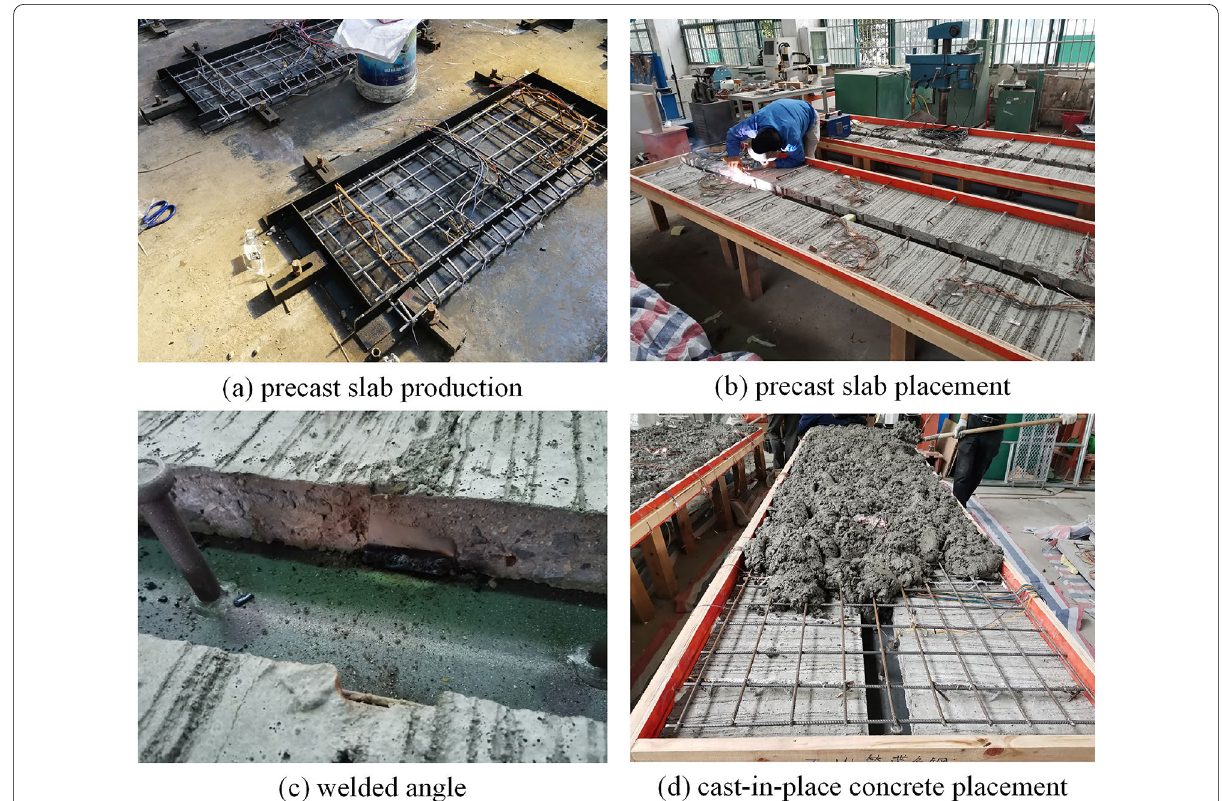
Fig. 4 The fabrication process of the composite beam with precast slab: a precast slab production, b precast slab placement, c welded angle, d cast-in-place concrete placement.